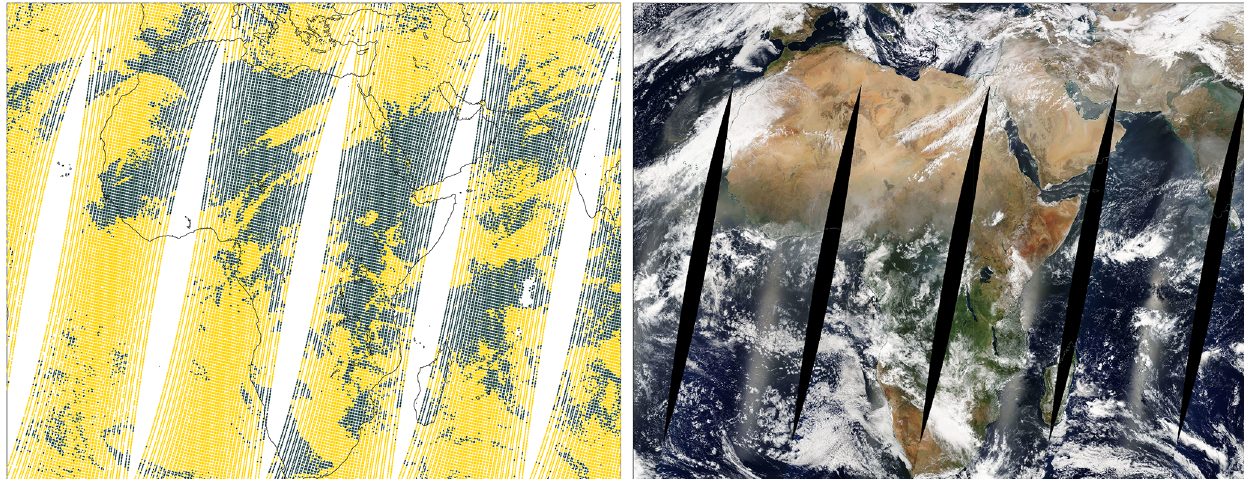
Figure 2. Left: example of cloud detection from the IASI neural network algorithm for 1d of measurements (15 February 2018, morning overpass). Cloud scenes are in yellow, clear-sky scenes in blue. Right: MODIS Terra-corrected reflectance (true colours) imagery for the same day (from NASA